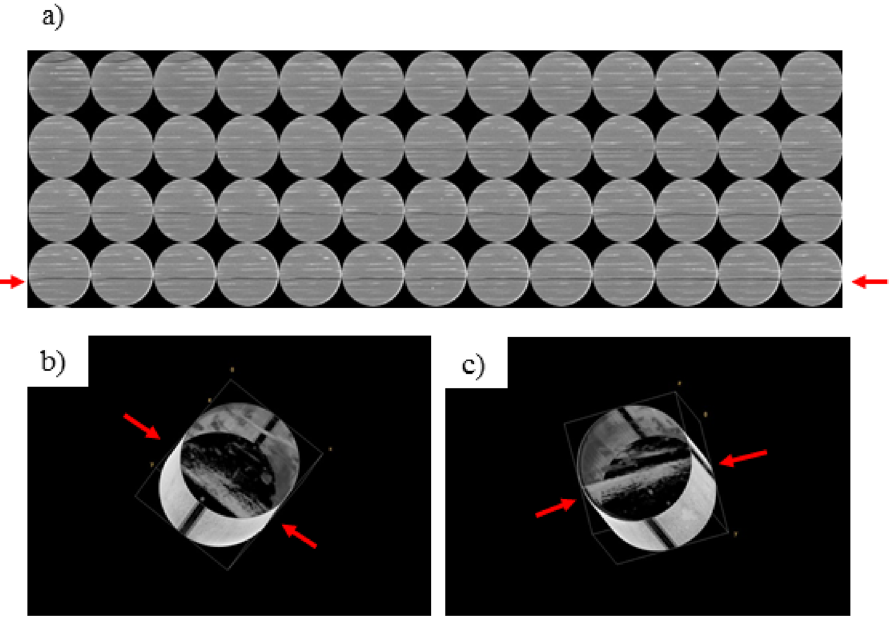
Figure 7. CT scanning images of 2D and processed 3D views of Duv 1–1: (a) 2D, top to bottom; (b) 3D, top to bottom; (c) 3D, bottom to top. A primary cemented lamination that is partly fractured is highlighted with the red arrows (a–c) . There is a secondary fracture close to the edge (a,b) that is not continuous along the core axis. Drafted using ImageJ (version 1.53a, https:// imagej.